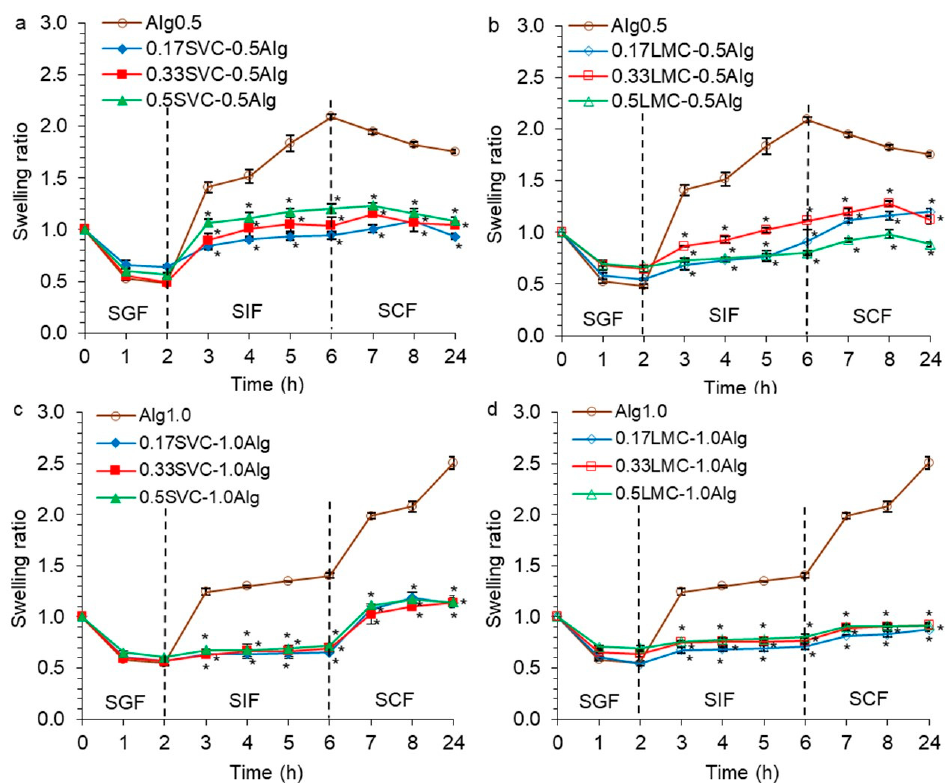
Figure 6. Swelling behavior of GSE-loaded hydrogels based on 0.5% alginate and SVC cells ( a ), 0.5% alginate and LMC cells ( b ), 1.0% alginate and SVC cells ( c ), 1.0% alginate and LMC cells ( d ) in the simulated gastric, intestinal, and colonic (SGF, SIF, and SCF, respectively) fluids. The data are presented as the mean ± S.D., n = 15. * p < 0.05 vs. 0.5 or 1.0% alginate.